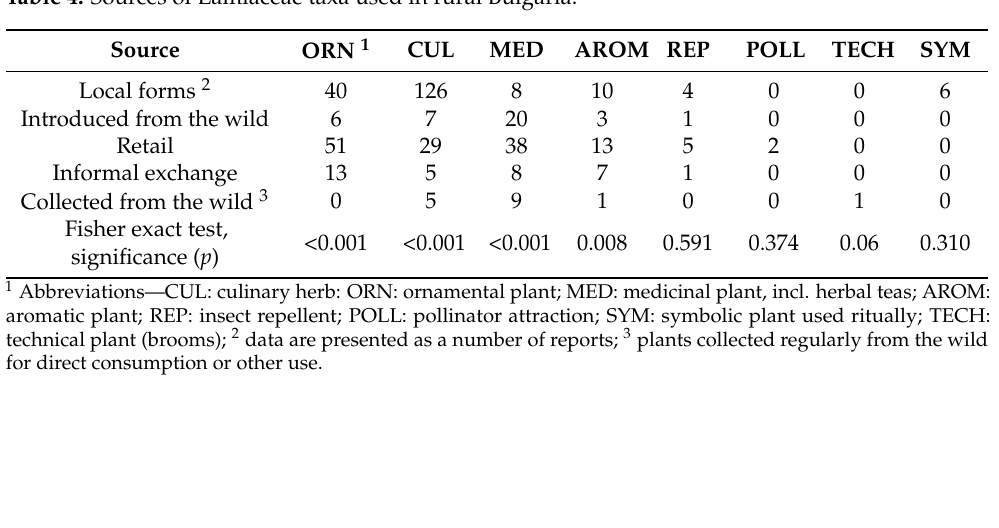
Table 4. Sources of Lamiaceae taxa used in rural